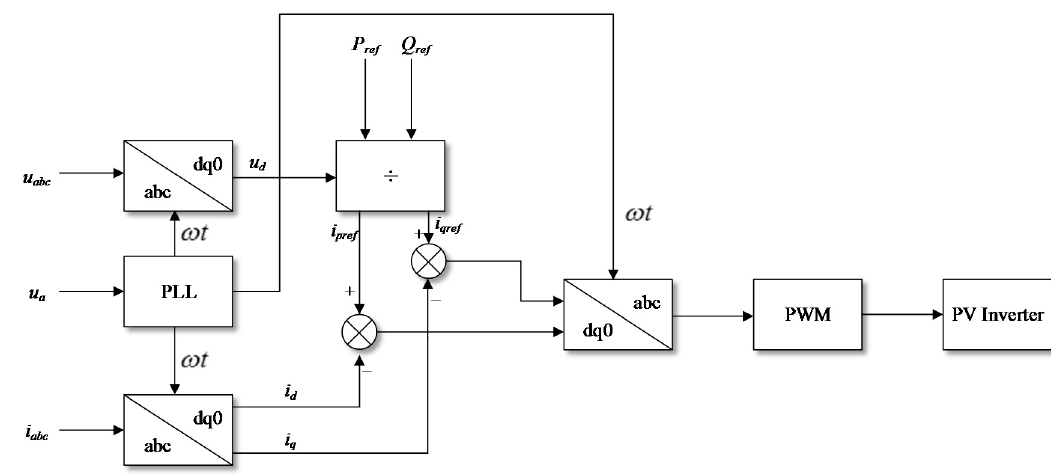
Figure 4. Structure diagram of the other three control modes except night control mode.